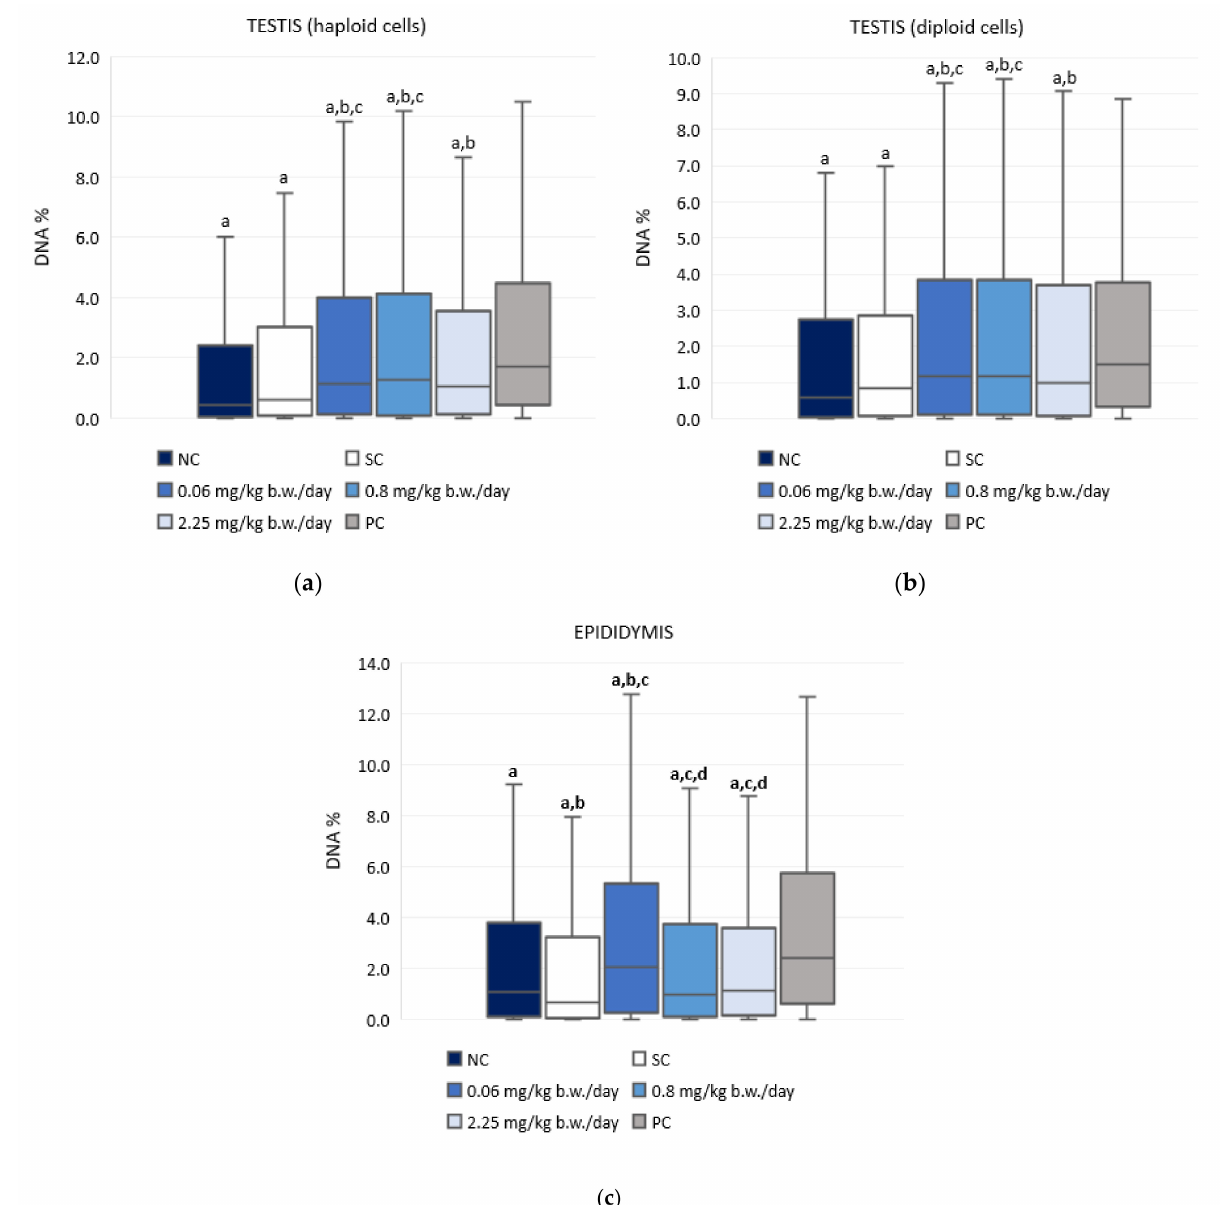
Figure 3. Results of the alkaline comet assay expressed as tail intensity (DNA%) in ( a ) testicular haploid, ( b ) testicular diploid, and ( c ) epididymal sperm cells of Wistar rats (N = 5 rats per group) treated orally for 28 consecutive days with imidacloprid at doses of 0.06 mg/kg b. w./day, 0.8 mg/kg b. w./day, and 2.25 mg/kg b. w./day and in the respective controls (NC—negative control, SC—solvent control, PC—positive control). Data are presented as median (line), 25th and 75th percentile (box), and range (whisker). Statistical significance was set at p < 0.05 (a—vs. positive control, b—vs. negative control, c—vs. solvent control, and d—vs. dose 0.06 mg/kg b.